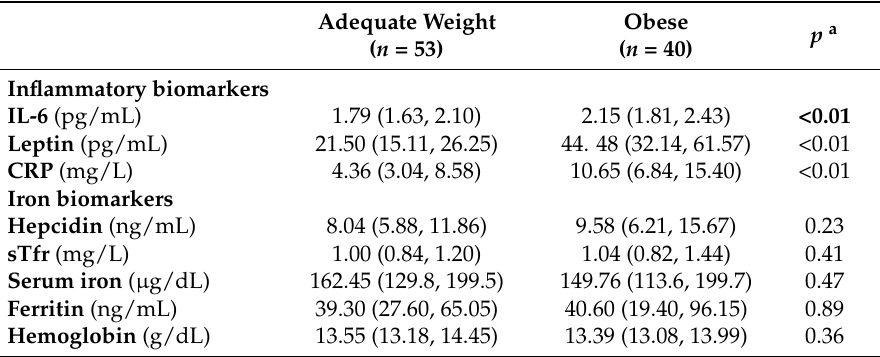
Table 2. Inflammatory and iron status biomarkers on the first study